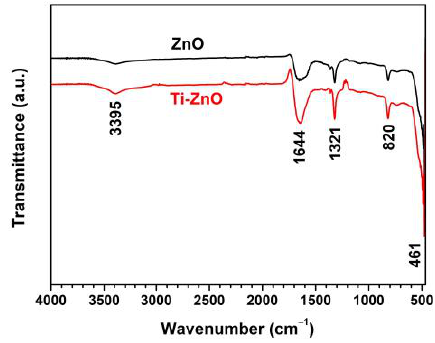
Figure 7. FTIR spectra of ZnO and Ti-ZnO NPs for surface chemical structure analysis.